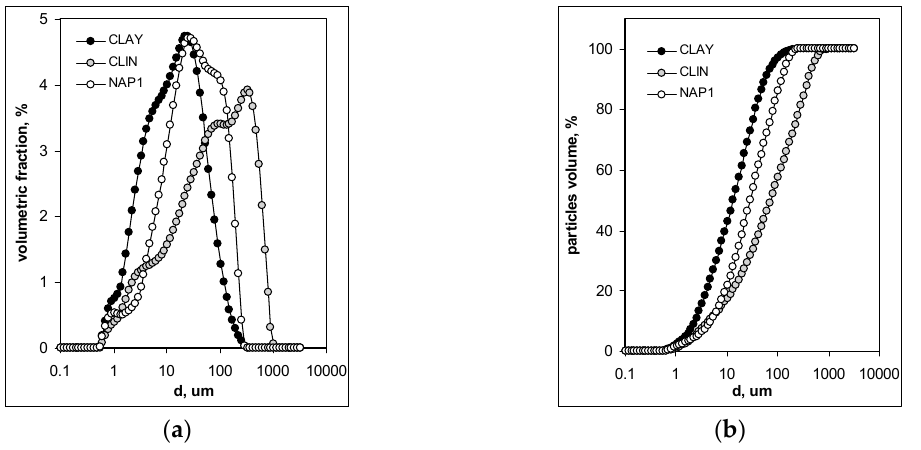
Figure 1. Particle size (diameter) distributions for the initial materials ( a ) and cumulative volume (scaled to 100%) versus particle diameter plot ( b ).